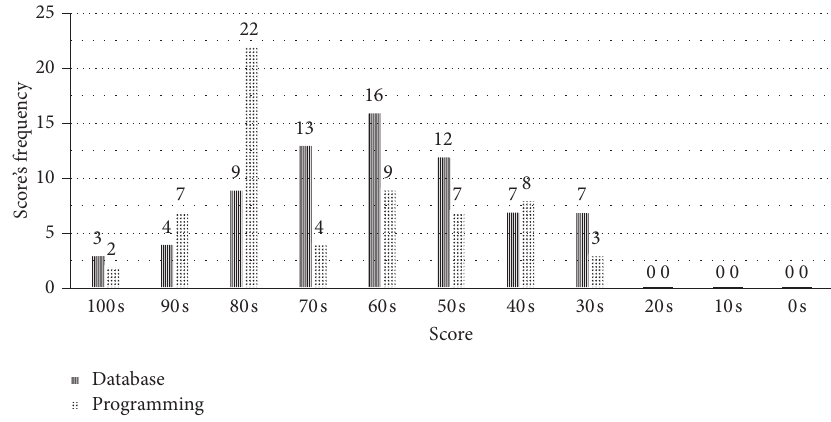
Figure 6: Domain-wise performance.